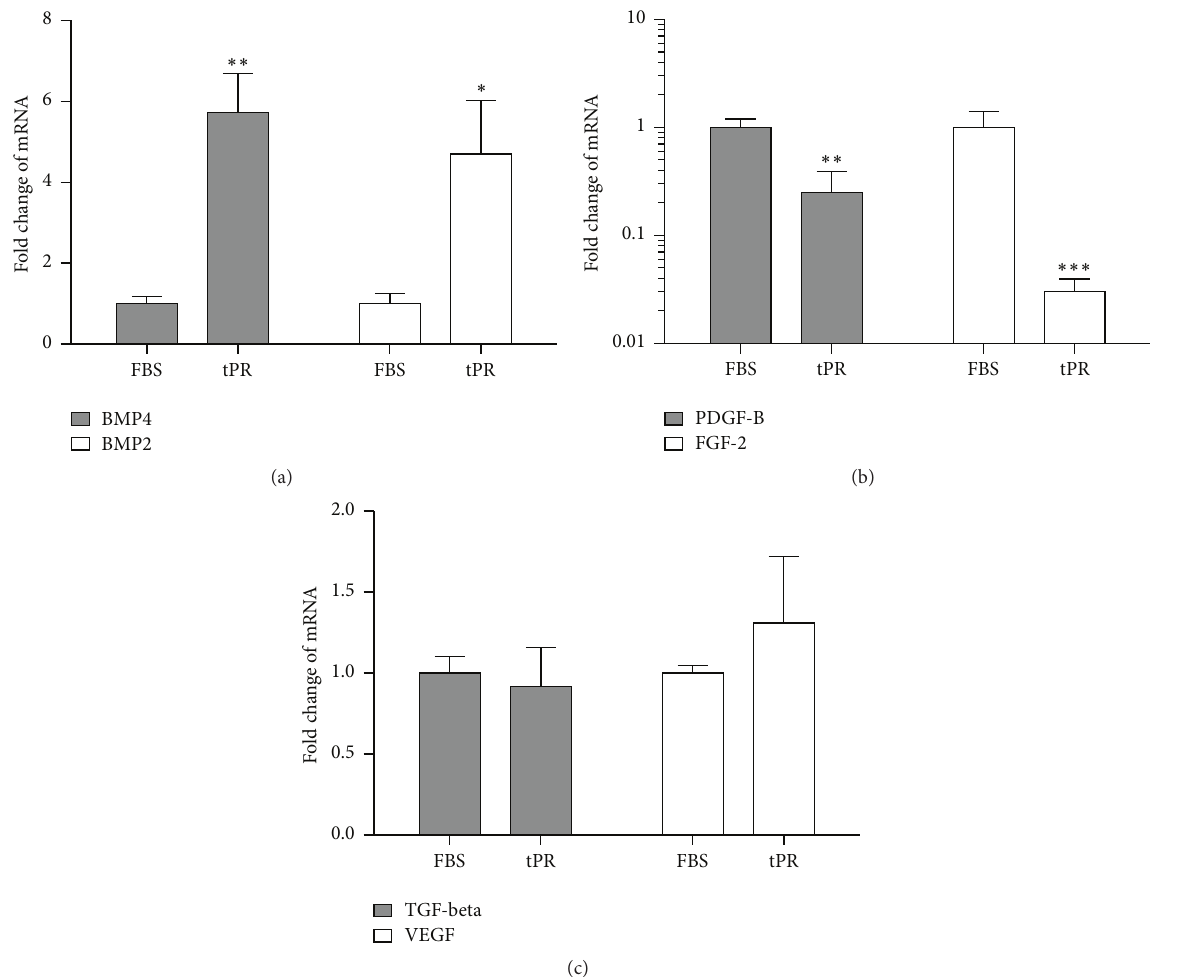
Figure 6: Gene expression in passage 1 ASCs grown in tPR. (a) tPR treated cells displayed an increase in BMP-2 and BMP-4 expression as compared to cells grown in FBS. (b) tPR treated cells displayed a decrease in PDGF-B and FGF-2 expression as compared to cells grown in FBS. (c) Expression levels of VEGF and TGF-beta did not change. RNA was isolated from cultured cells using the BioRad Aurum minikit and rt-PCR was performed using GAPDH and RP13A as reference genes ( ∗ 𝑃 < 0.05 , ∗∗ 𝑃 < 0.01 , and ∗∗∗ 𝑃 < 0.001